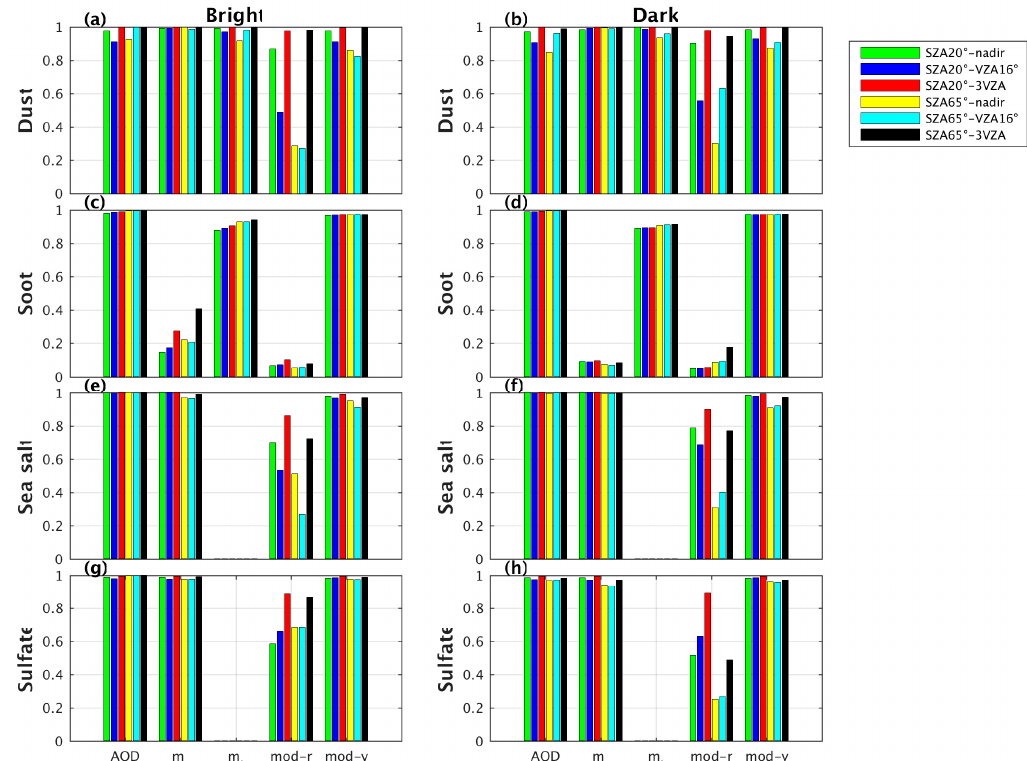
Figure 3. The degrees of freedom for the signal (DFS) of corresponding aerosol parameters at different viewing angles in high and low solar zenith angles for four types of aerosol over the bright and dark surface defined as in Section 4. The left column is for the bright surface, and the right column is for the dark surface. Four rows represent four aerosol types: dust ( a , b ), soot ( c , d ), sea salt ( e , f ) and sulfate ( g , h ). Different colored bars represent corresponding different observation geometries. The X -axis represents five retrieved aerosol parameters: AOD, real (m r ) and imaginary part of refractive index (m i ), mode radius (mod-r) and variance (mod-v) of PSD.